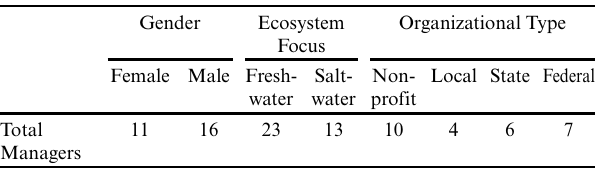
Table 1 . Characteristics of individuals in the restoration community interviewed for this study, including gender, freshwater and/or saltwater focus, and organizational affiliation. Gender Ecosystem Organizational Focus